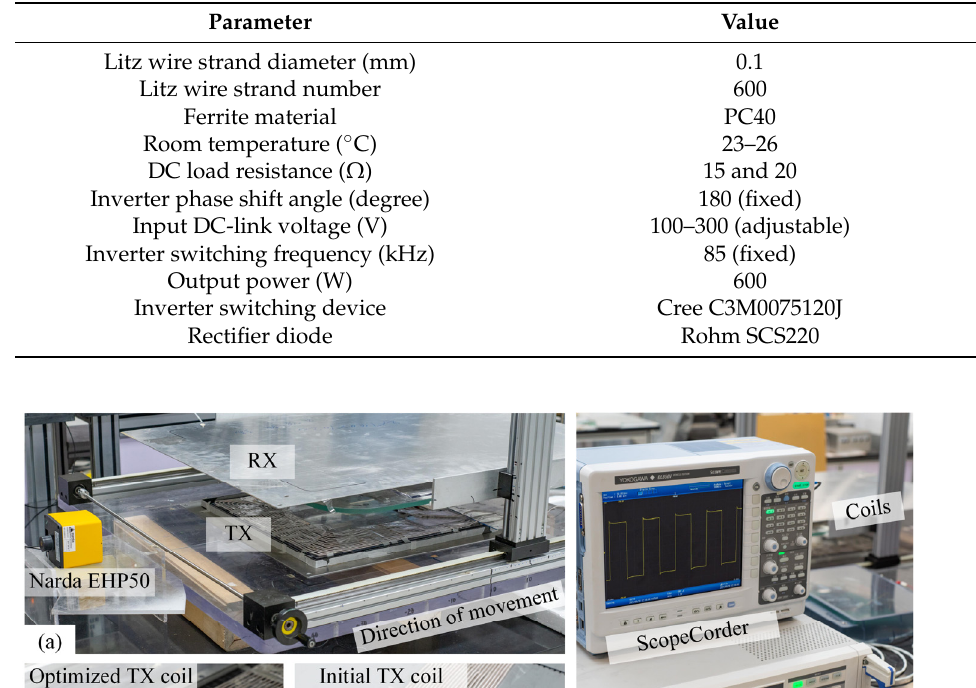
Table 5. Specifications of the IPT prototype.